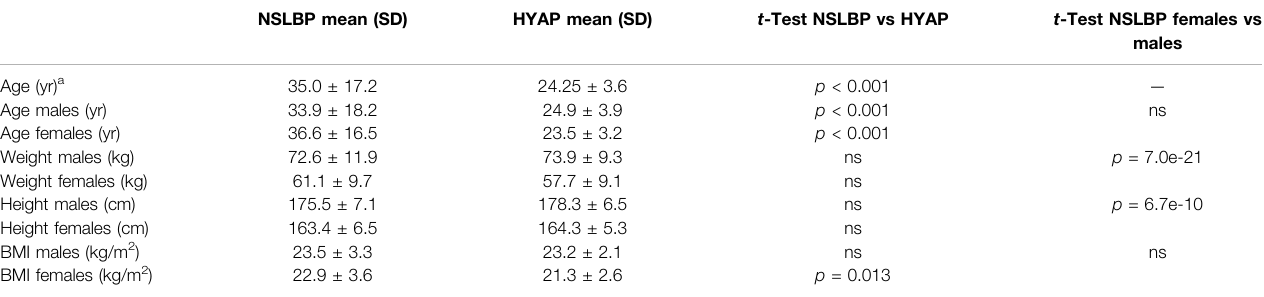
TABLE 1 | NSLBP Patients Characteristics Compared to Healthy Young Adults Characteristics. The last column reports the comparison between males and female characteristics in the NSLBP patients ’ cohort (total = 80 NSLBP